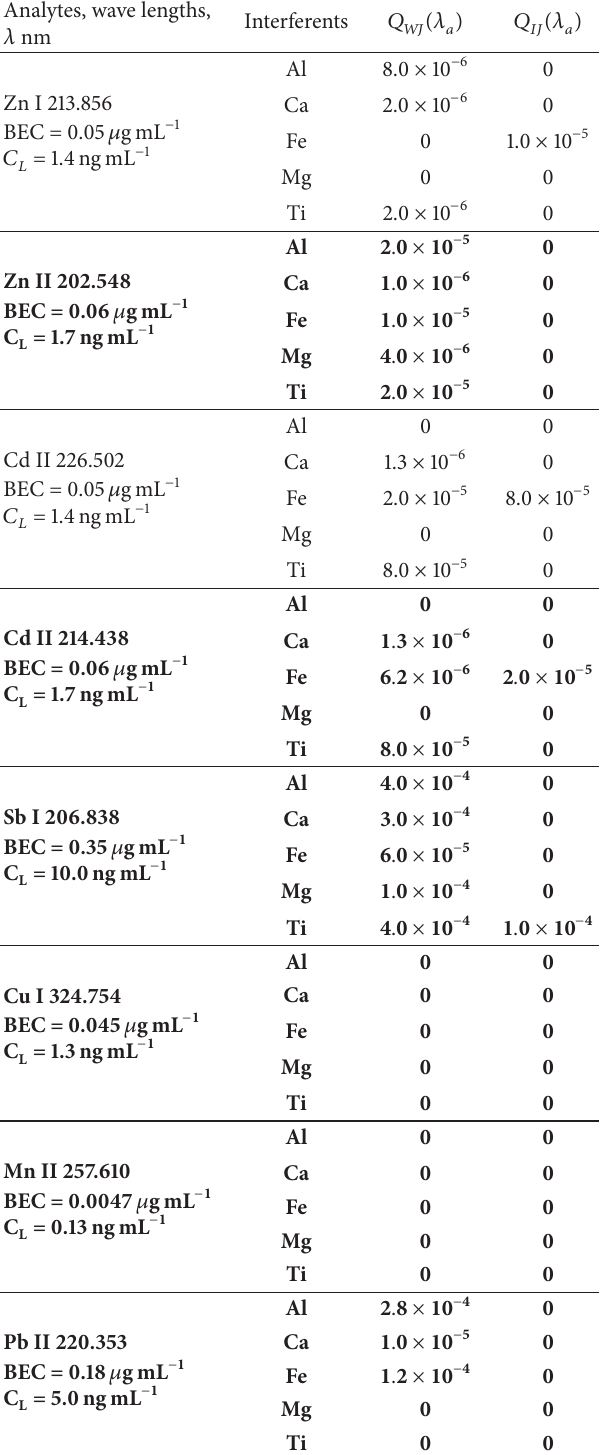
Table 2: Quantitative values for line interferences [ 𝑄 𝐼𝐽 ( 𝜆 𝑎 )] and wing background interference [ 𝑄 𝑊𝐽 ( Δ𝜆 𝑎 )] in the determination of trace of elements Zn, Cd, Sb, Cu, Mn, Pb, Sn, Cr, U, and Ba. Interferents: Al, Ca, Fe, Mg, and Ti. The data listed under the wavelength of the prominent lines refer to background equivalent concentrations in pure solvent (BEC) and detection limits in pure solvent ( 𝐶 𝐿 ).